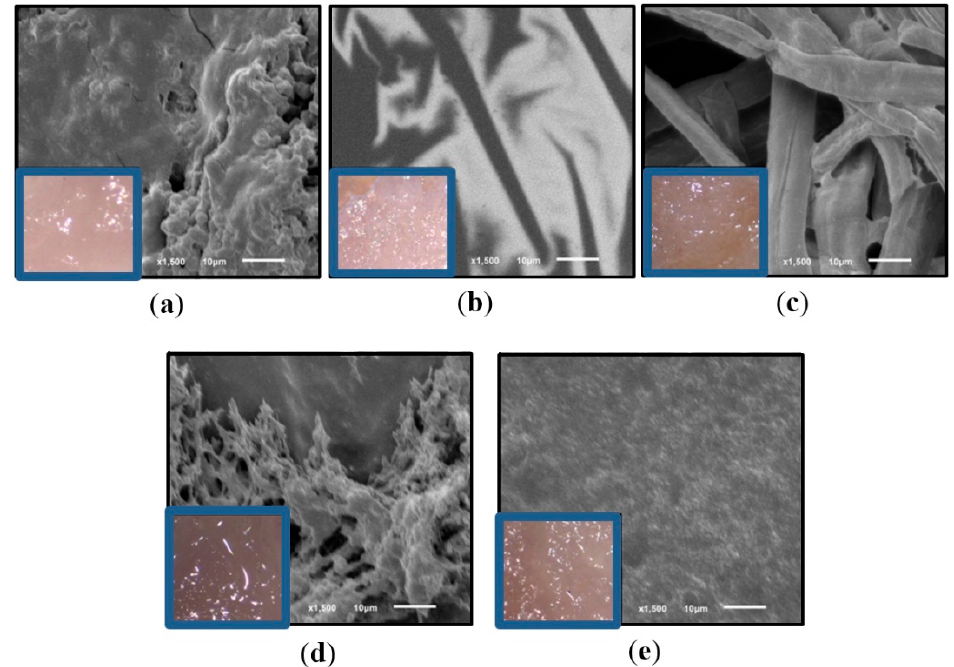
Figure 5. Cellulose pulp treated after washing SEM images (1500 × ) and optical images (35 × —blue squares) for pulp samples treated with the corresponding IL: ( a ) [bmim][Ac]; ( b ) [bmim][Cl]; ( c ) [bmim][HSO 4 ]; ( d ) [emim][Ac]; ( e ) [emim][Cl].